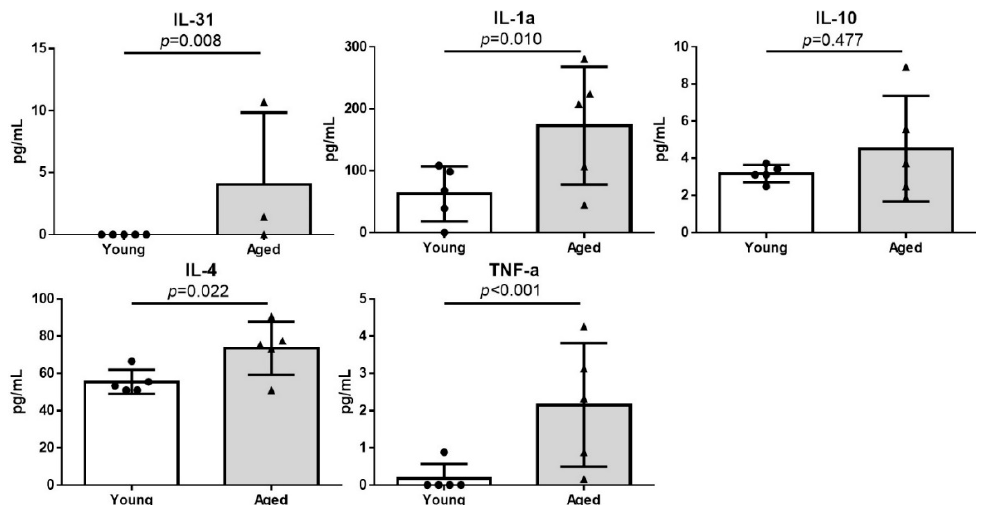
Figure 4. Inflammatory cytokine levels in the serum of young and aged hairless mice. Concentrations of inflammatory cytokines were significantly higher in the serum of aged mice. The data are presented as the means ± SD. IL, interleukin; TNF, tumor necrosis factor.